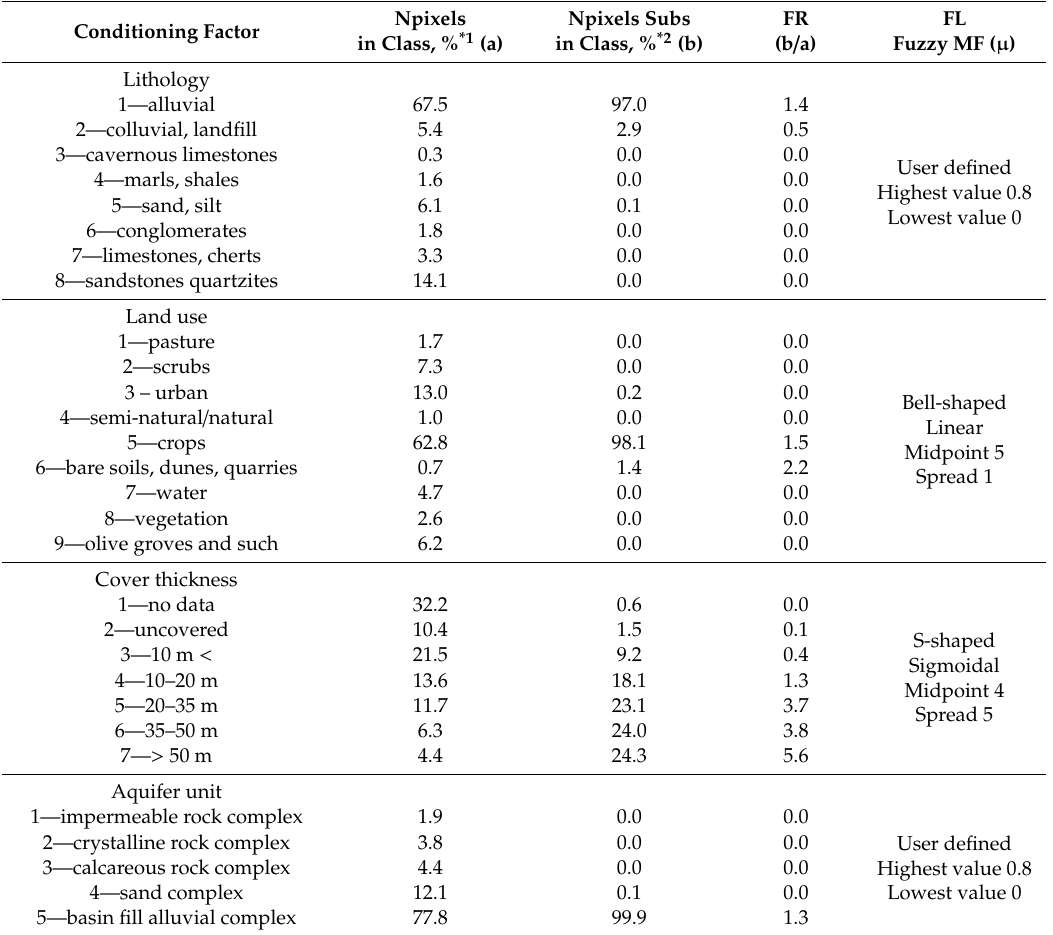
Table A1. Predisposing factors, their classifications, pixel computations, FR and FL assessment for past subsidence inventory (2003–2009) derived from ENVISAT PS